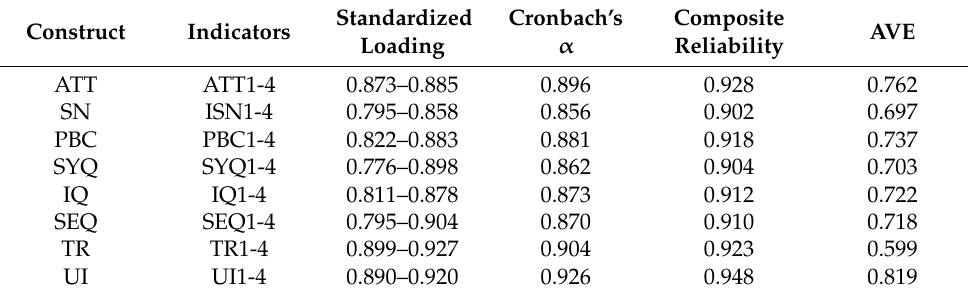
Table 2. convergent validity and reliability (Entire Samples).